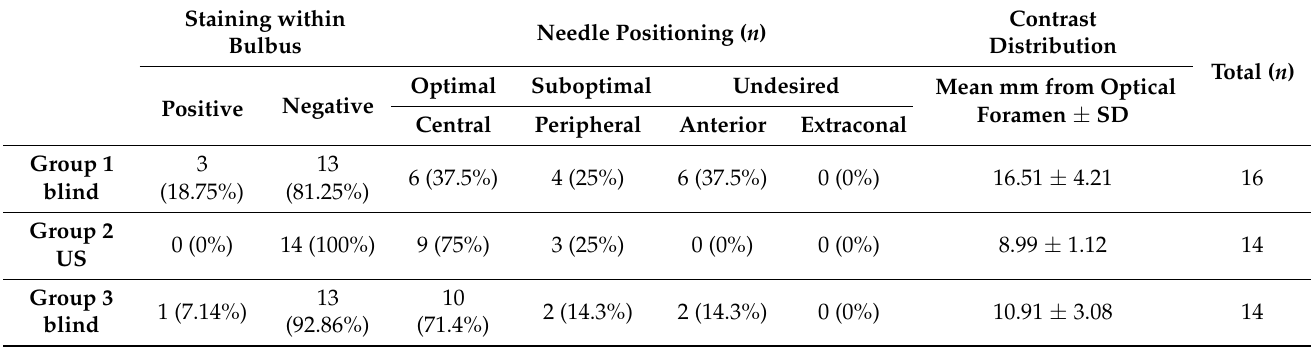
Table 2. Variables measured in the different groups (1–3): The number of RNBs that showed staining of methylene blue dye within the bulbus at dissection (positive) versus the number of